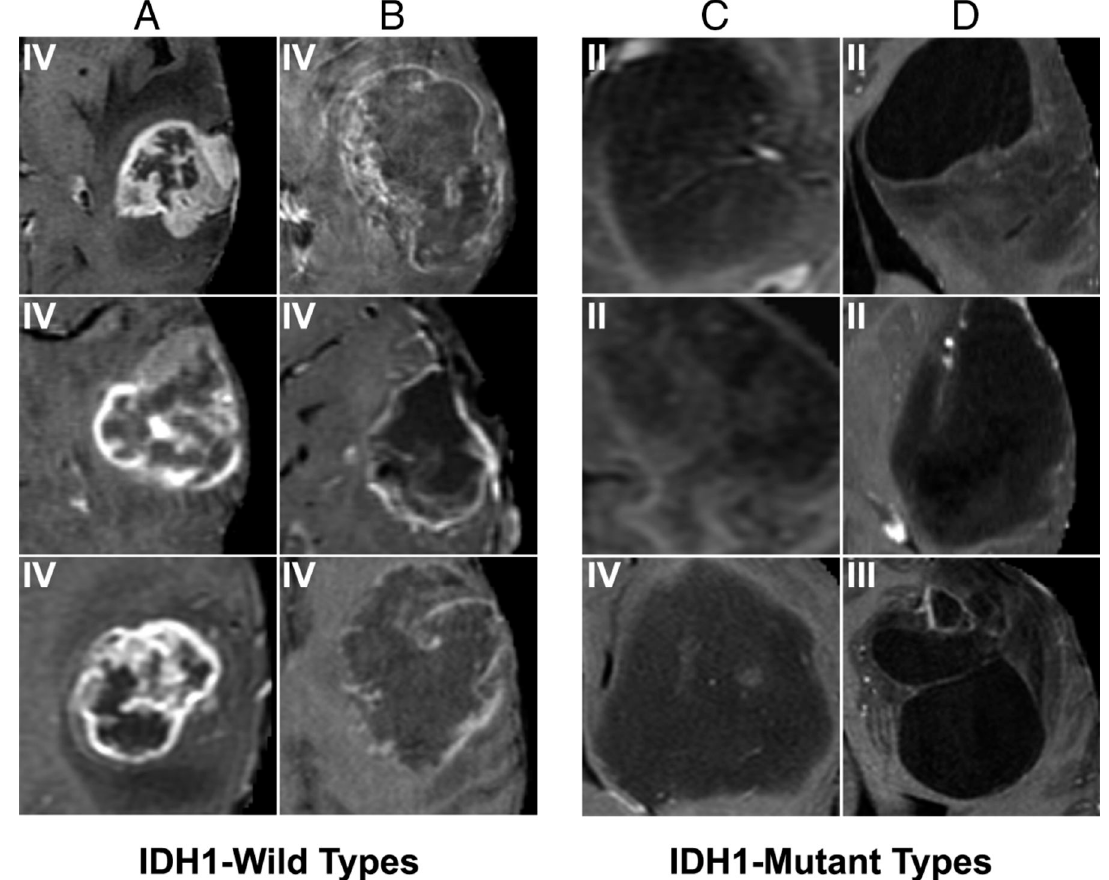
Figure 3. Prototypical imaging features associated with IDH mutation status [59]. Our CNN demonstrated that T1 post-contrast features predict IDH1 mutation status. Specifically, IDH wild types are characterized by thick and irregular enhancement ( A ) or thin, irregular, poorly-margined, peripheral enhancement ( B ). In contrast, patients with IDH mutations show minimal enhancement ( C ) and well-defined tumor margins ( D ).